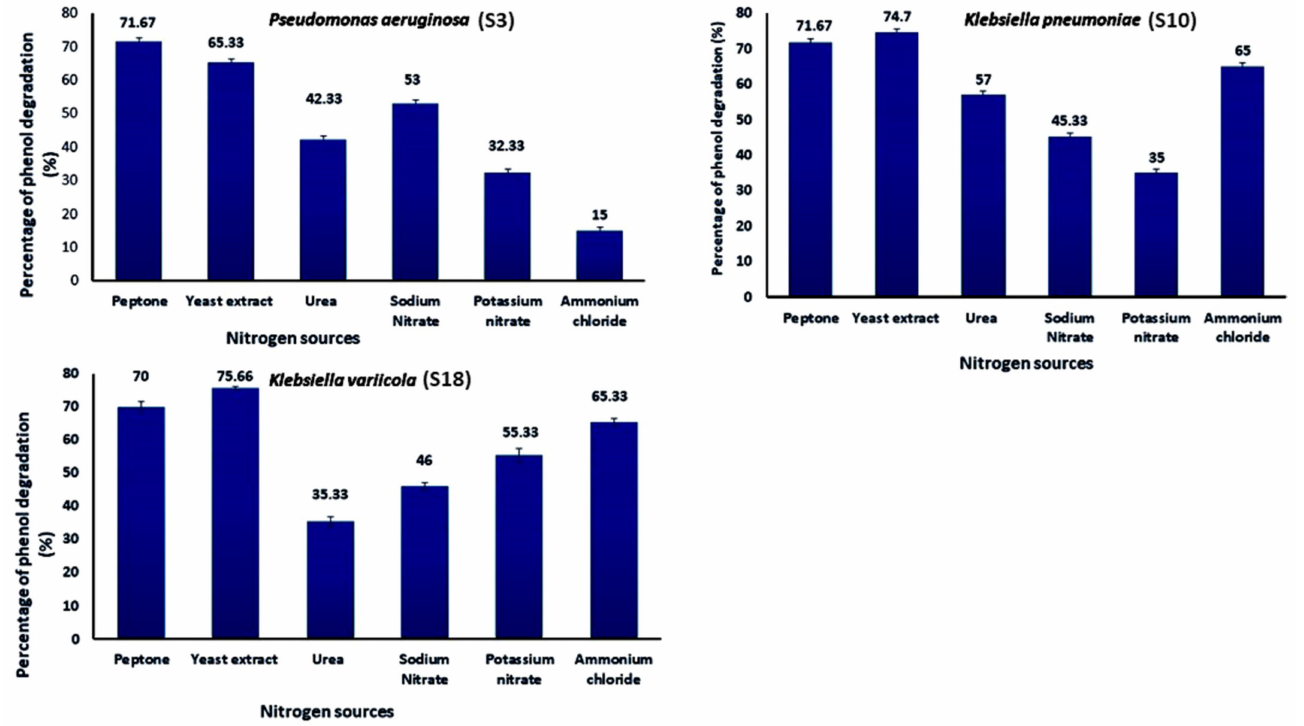
Figure 6. Effect of N sources on phenol biodegradation by Pseudomonas aeruginosa (S3), Klebsiella pneumoniae (S10), and Klebsiella variicola (S18) (initial phenol concentration was 1000